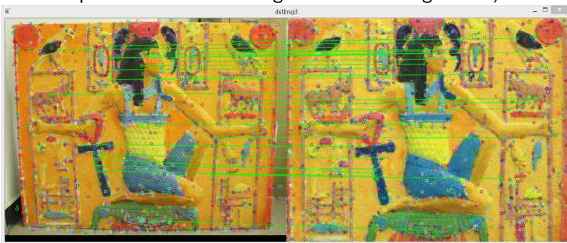
Figure 11. Registration results of global image and point cloud image 3. The local image is matched with the whole image, and the local image corresponding to the local point cloud RGB image is obtained by parameter conversion, such as figure 12, figure 13, figure 14;